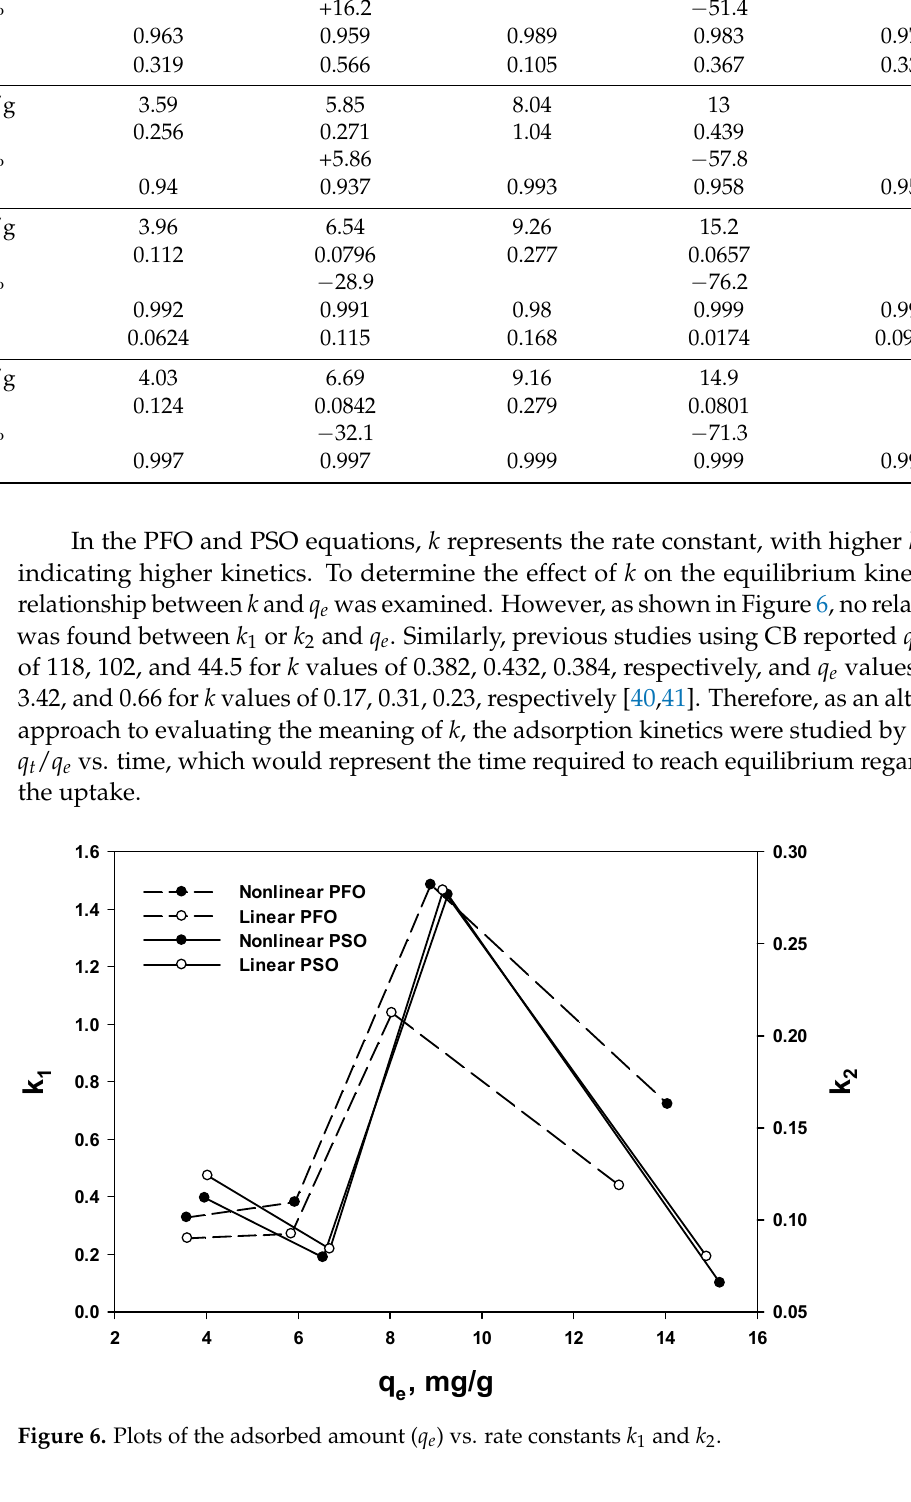
( b ) Figure 7. Plots of q t / q e versus time using pseudo-first-order (PFO) ( a ) and pseudo-second-order (PSO) kinetic models ( b ).